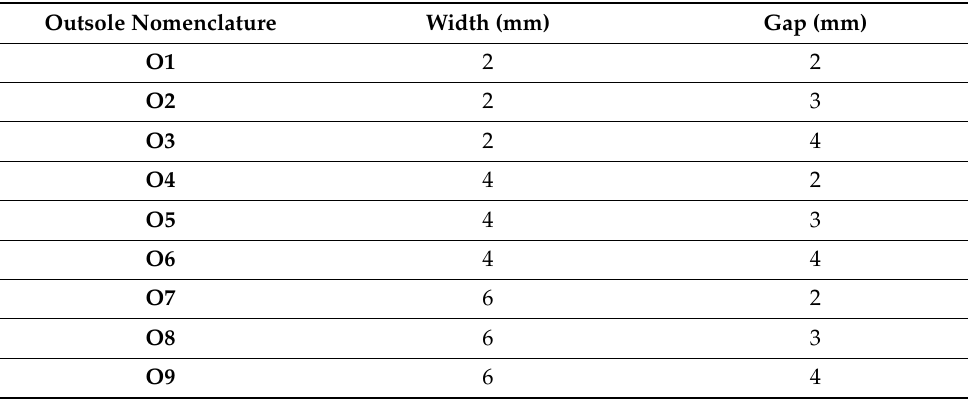
Figure 1. Dimensions of the original footwear’s tread design. Table 1. Parametrical modifications in the outsole’s design.